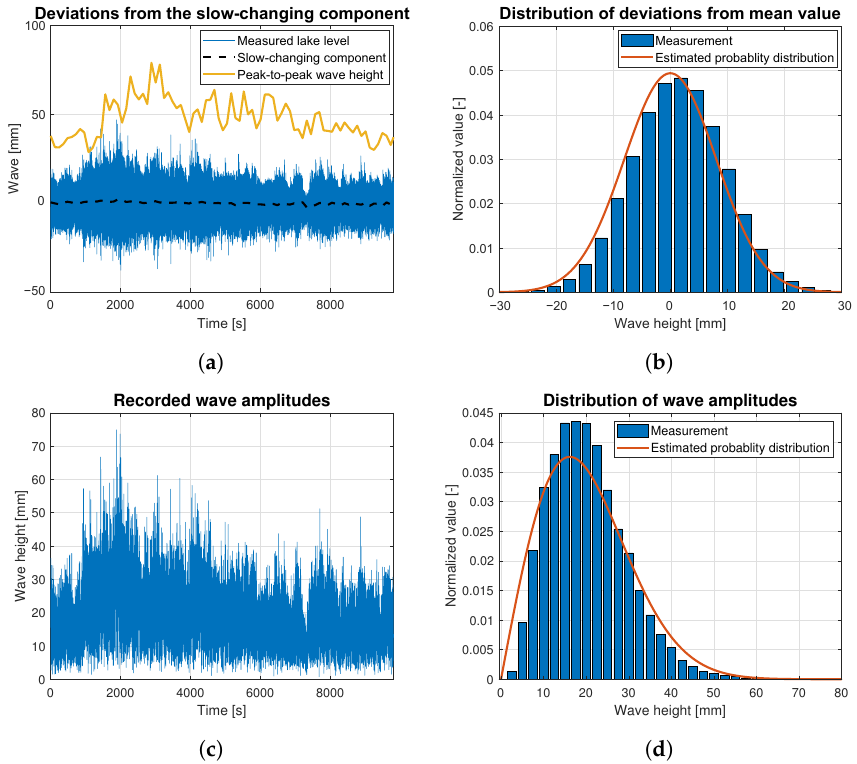
Figure 14. Statistical analysis of the wave height corresponding to 9 BFT wind force in ship scale: ( a ) deviations from the slow-changing component; ( b ) probability distribution of wave height deviations from mean value; ( c ) recorded wave amplitudes; ( d ) probability distribution of wave height